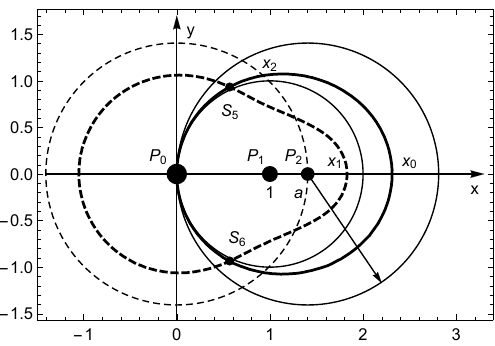
Figure 2. Points of intersections of the curves f 1 ( x,y ) = 0 and f 2 ( x,y ) = 0 define the triangular equilibrium positions S 5 and S 6 , µ 1 = 0 . 1, µ 2 = 0 . 04, a > 1.